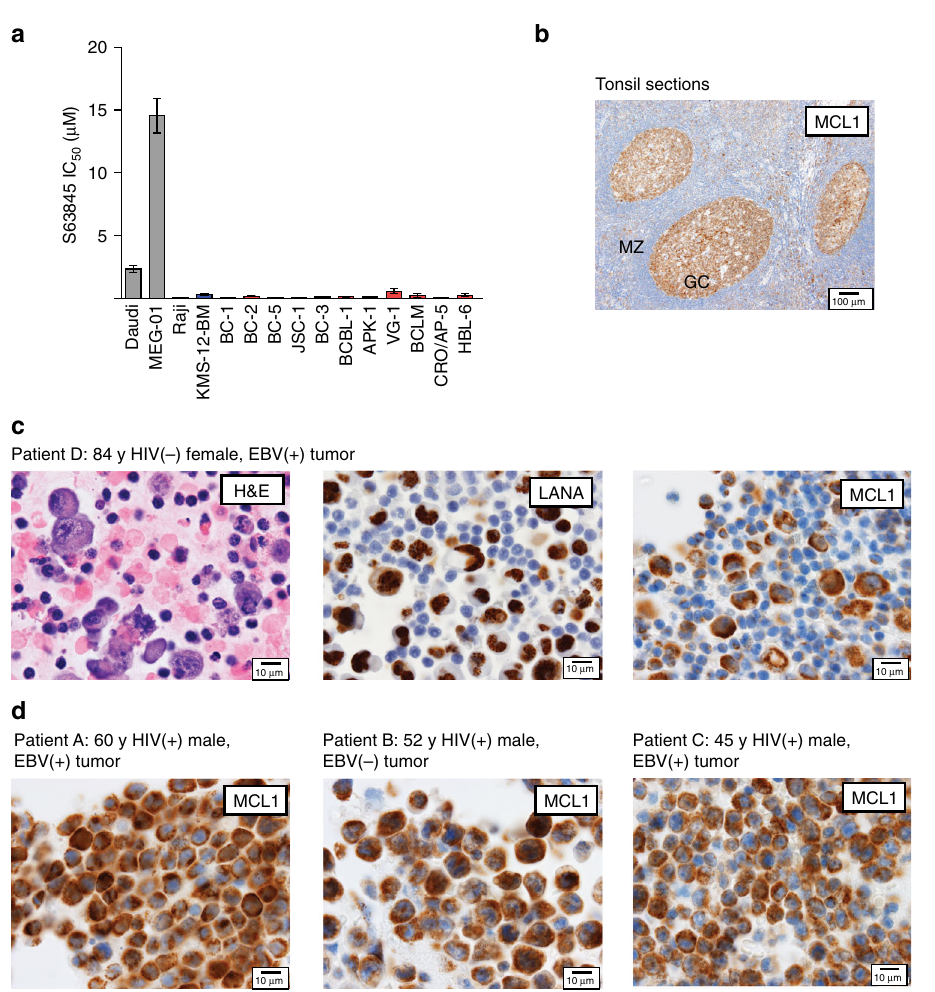
Fig. 6 Pharmacological inhibition of MCL1 in PEL and control cell lines and MCL1 expression in PEL tumors. a Calculated IC 50 values of S63845 in different cell lines. Based on Kotschy et al. 53 , Daudi and MEG-01 cells are MCL1-independent cell lines while Raji and KMS-12-BM are MCL1-dependent cell lines. Error bars, SEM; n ≥ 3 biological replicates. b MCL1 staining in tonsilar sections con fi rms speci fi city of our staining protocol. Germinal center cells (GC) express high levels of MCL1 while mantle zone cells (MZ) express low to undetectable levels of MCL1. c Example of a histological characterization of tumor sections from patient D (84-year HIV( − ) female with EBV( + ) tumor) with hematoxylin and eosin staining (H&E), LANA immunohistochemical stain, or MCL1 immunohistochemical stain. d MCL1 immunohistochemical stains for tumor sections from patients A – C. Corresponding scale bars are depicted in lower right corner of each